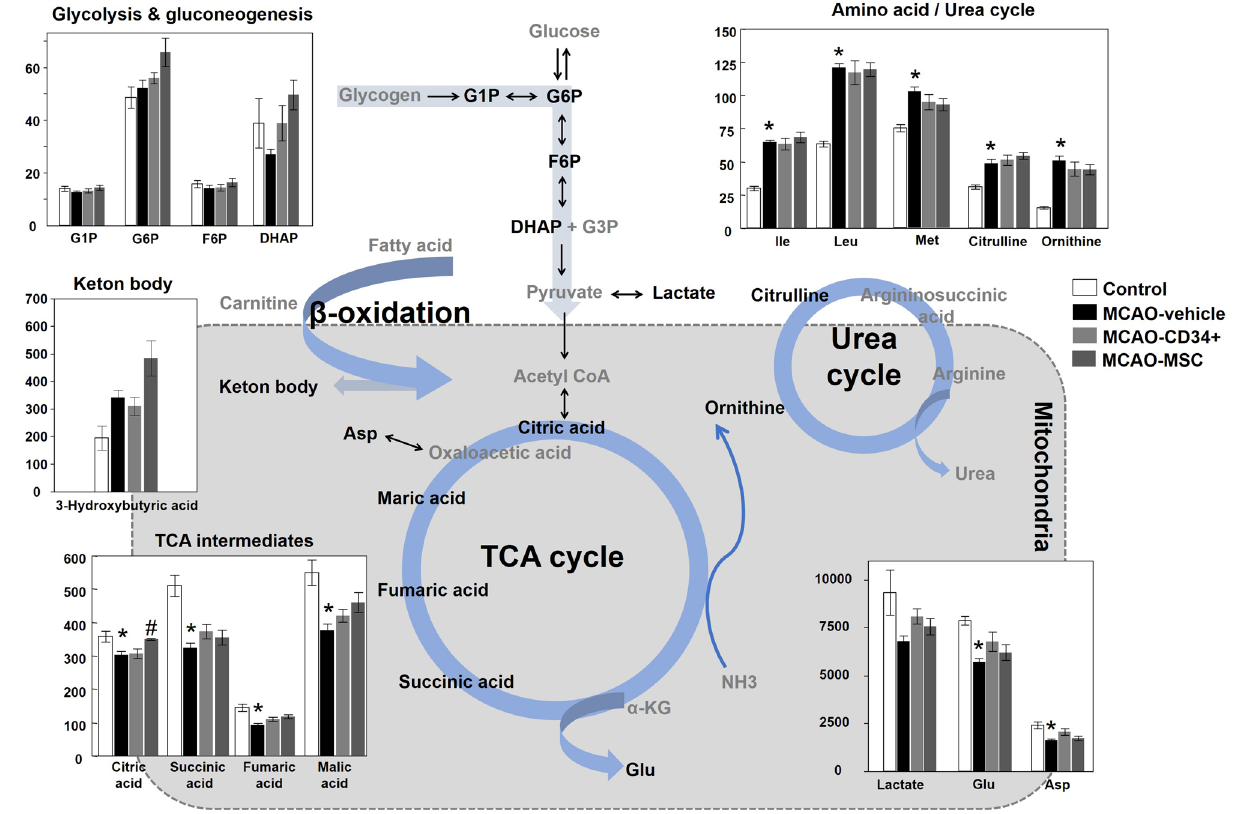
Figure 5. Central metabolic pathway map and comparative visualization of involved metabolites after MCAO. Differences in the brain levels of metabolites among the control, MCAO-vehicle, MCAO-CD34 + cell, and MCAO-MSC groups are presented in a bar graph. MCAO decreased TCA intermediates and neurotransmitter metabolites, while MCAO increased metabolites from the amino acid and urea cycles. Data indicate the mean ± the S.E.M. of five mice for each group. * p < 0.05 versus the control group. # p < 0.05 versus the